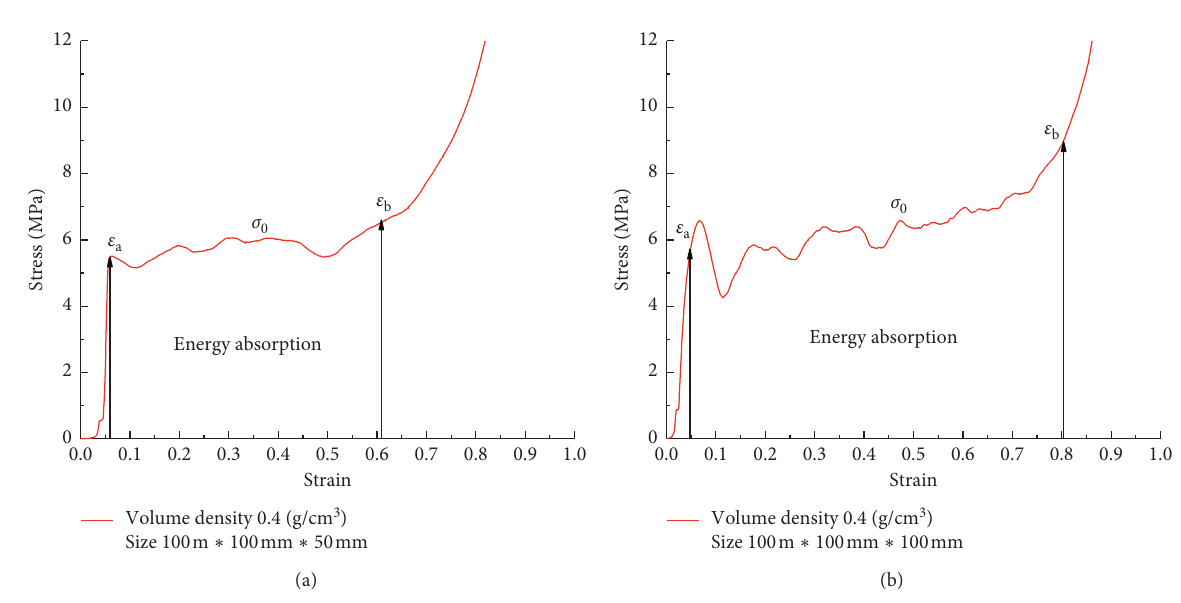
Figure 3: Stress-strain curves of closed-cell aluminum foam under the uniaxial compression test. Table 2: Parameters of closed-cell aluminum foam material.